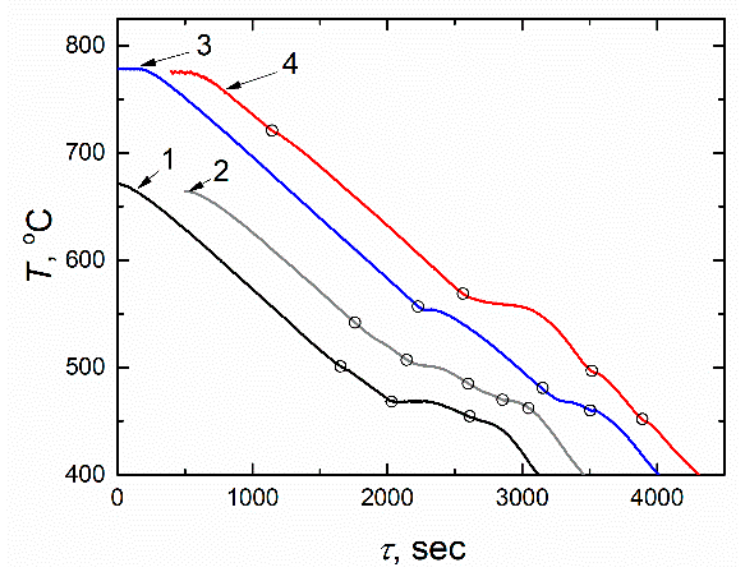
Figure 5. Temperature versus time during cooling of FLiNaK with different NdF 3 contents (mol.%): 1—6, 2—15, 3—20, 4—30.